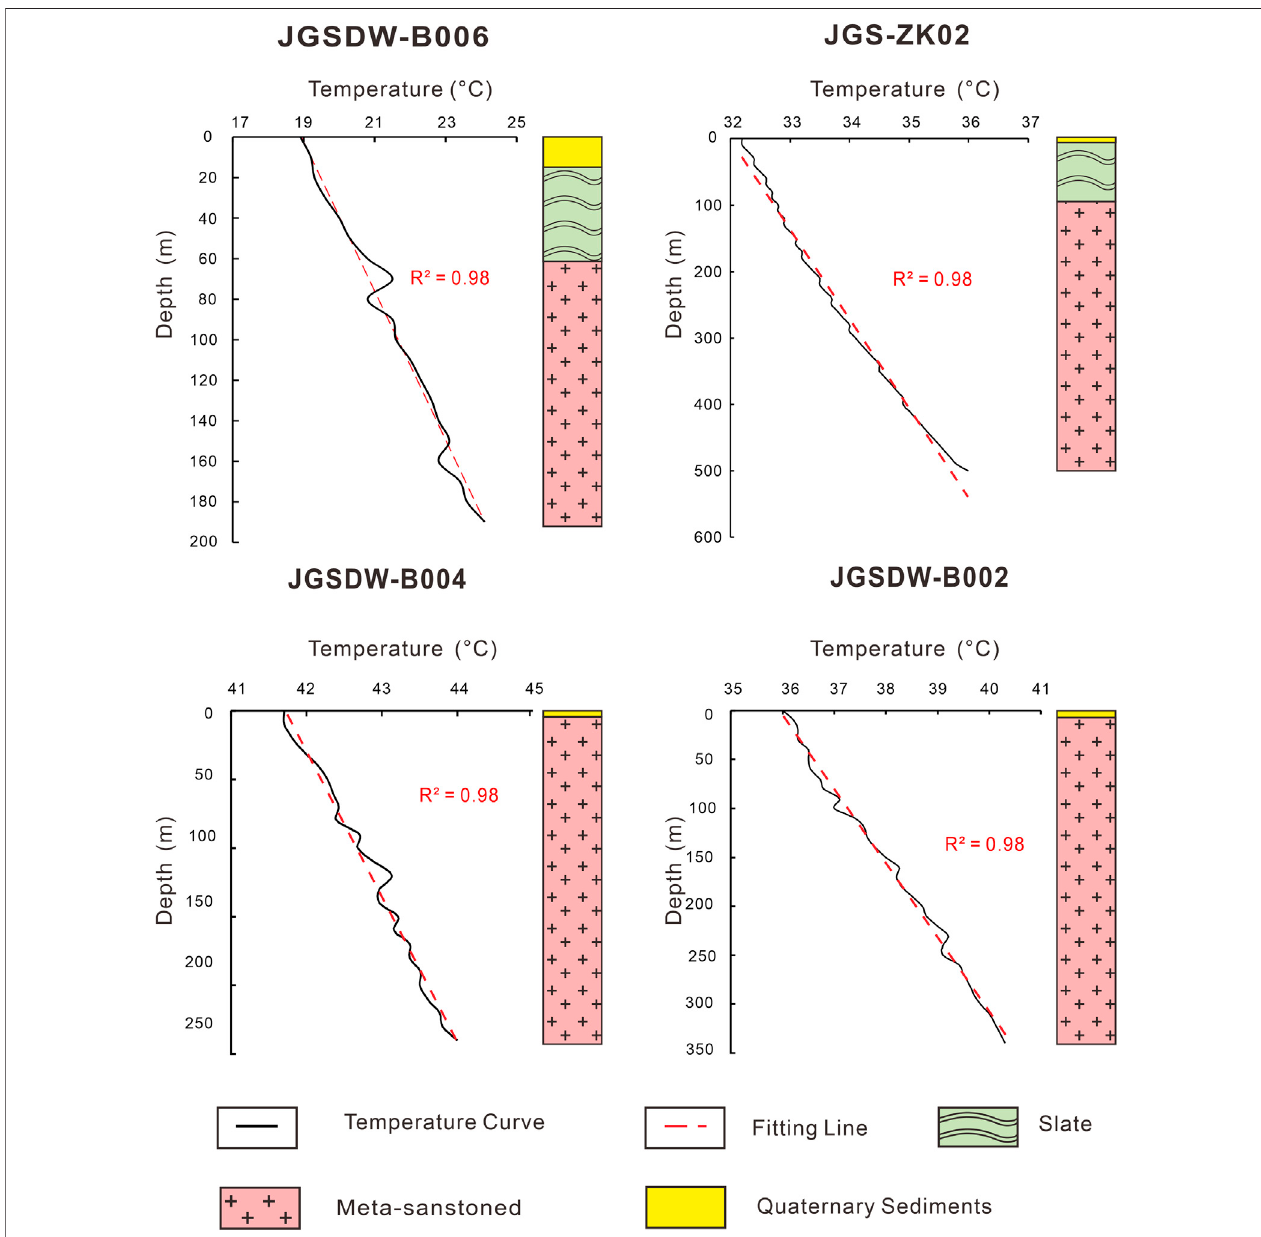
FIGURE 3 | Temperature – depth pro fi les for the wells in Huang ’ ao and Qutan villages.